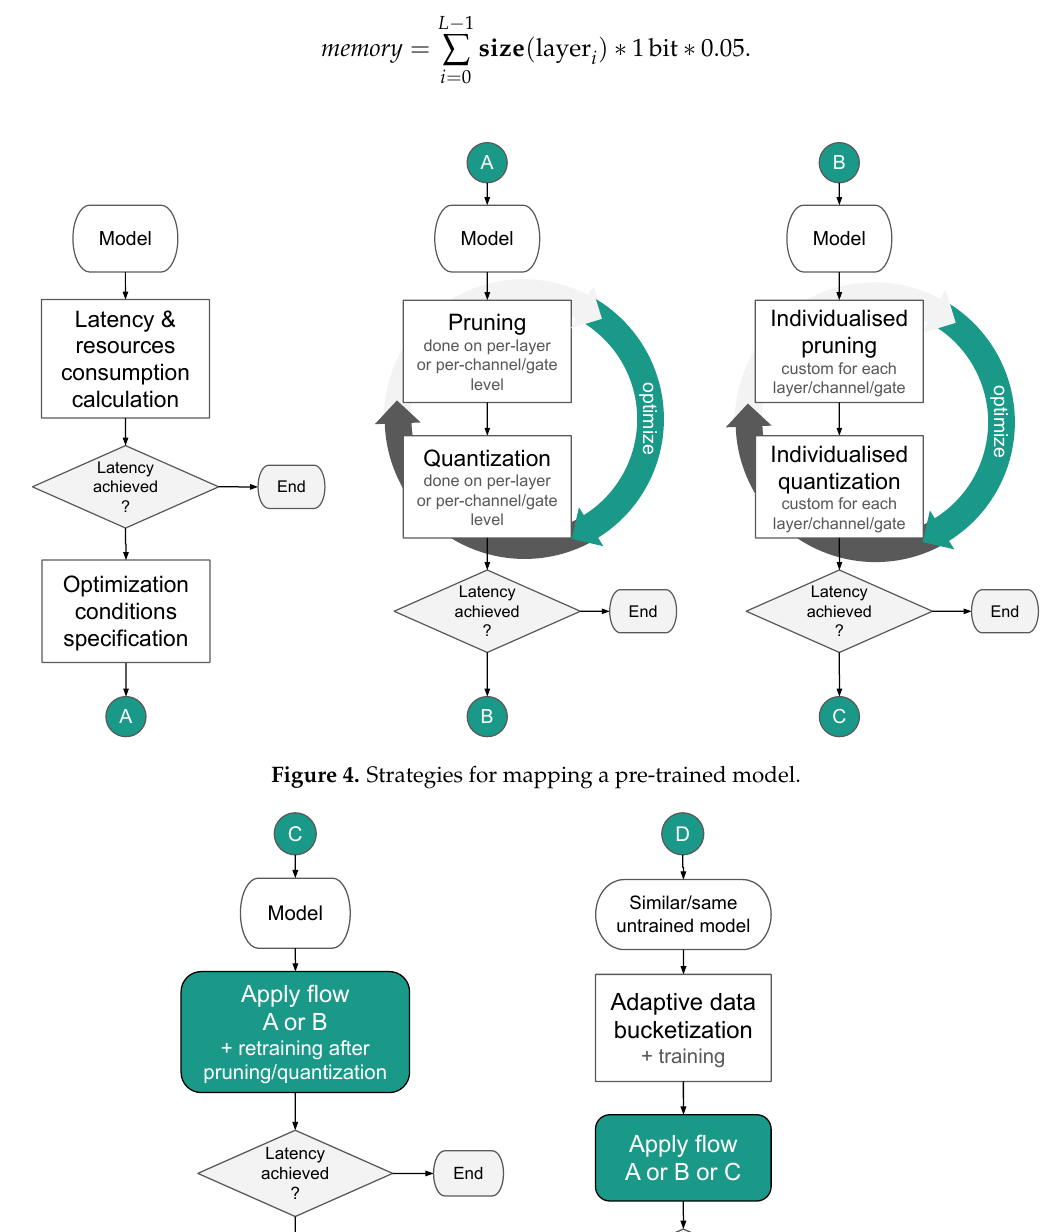
Figure 5. Advanced strategies for model